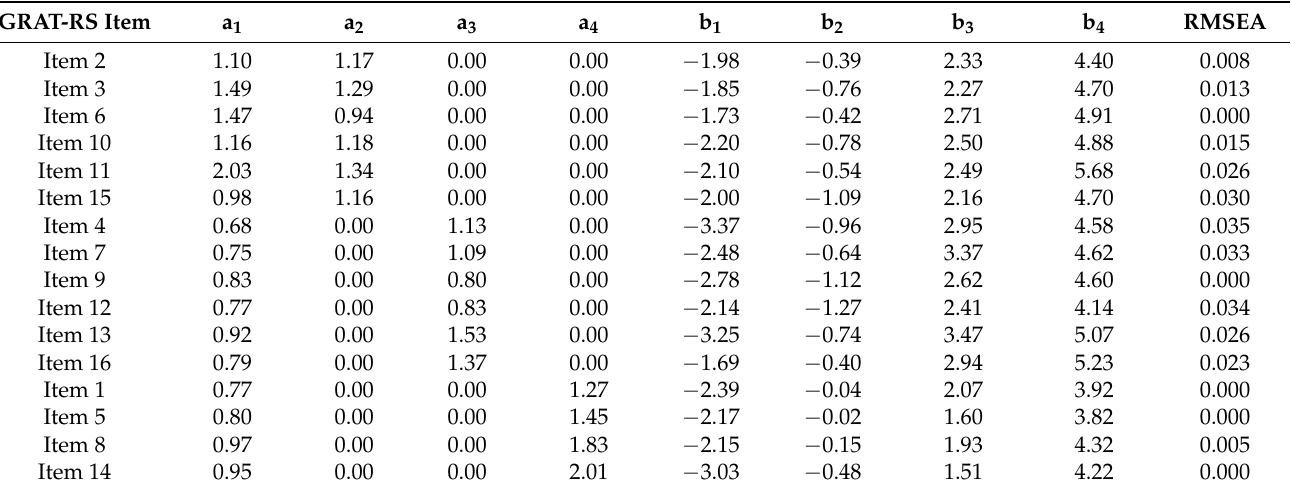
Table 4. The Gratitude Resentment and Appreciation Test-Revised Short (GRAT-RS): multidimen- sional item response theory (MIRT) analyses. Discrimination and difficulties parameters (grade response model) ( n = 537).